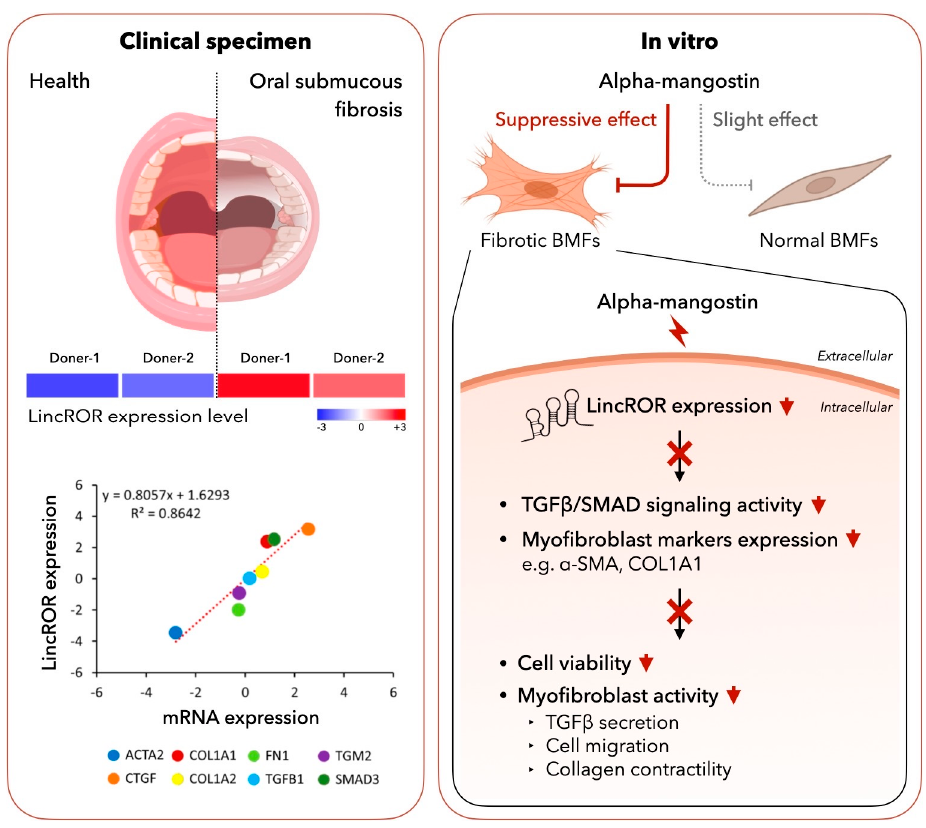
Figure 7. Schematic representation of the therapeutic potential of α -mangostin in OSF. LincROR is upregulated in OSF tissues using RNA-Seq and positively correlated with various fibrosis markers ( left panel). α -mangostin inhibits myofibroblast characteristics, including cell proliferation, activities and marker expression as well as TGF- β 1 signaling ( right panel).